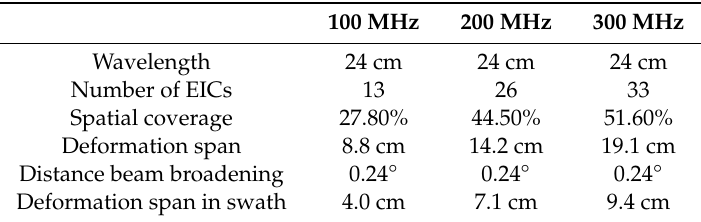
Table 3. Observational e ff ects of three signal